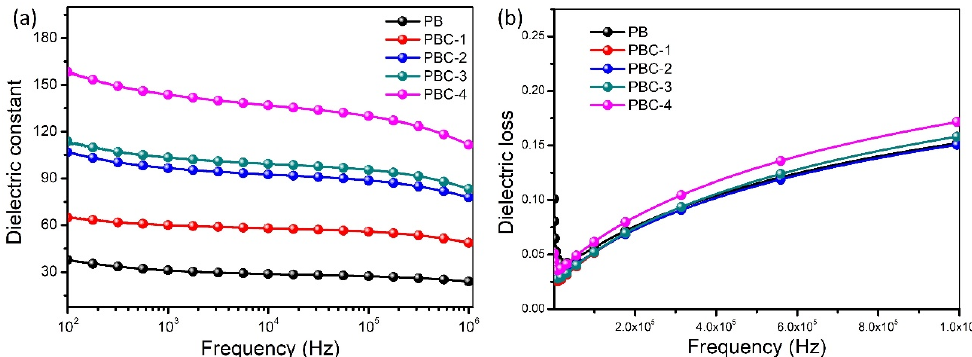
Figure 6. Dielectric properties of the as ‐ prepared PB and PBC films—( a ) dielectric constant and ( b ) dielectric loss.